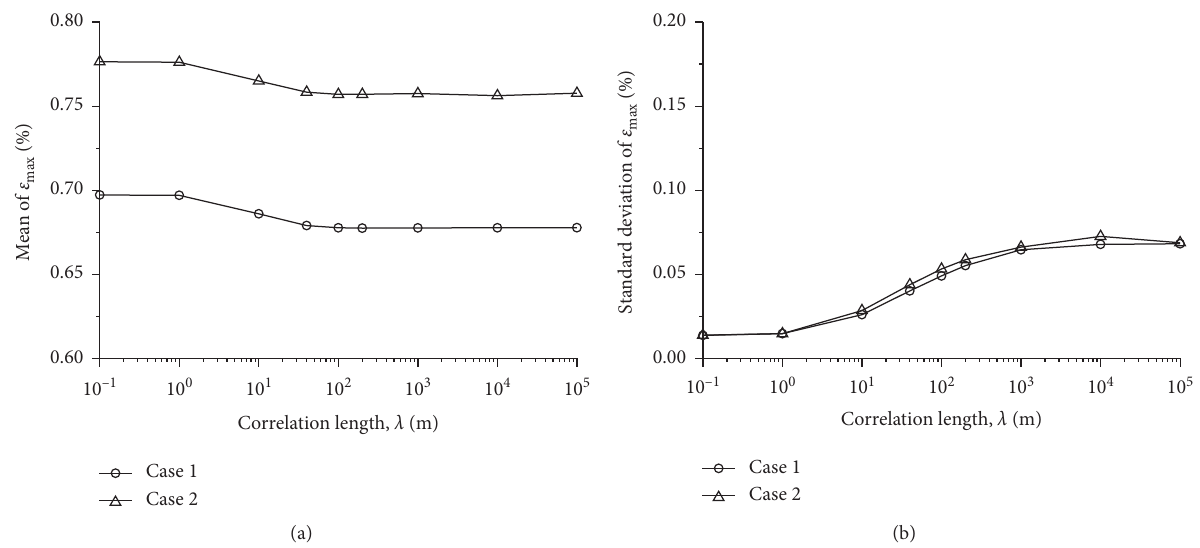
max : (a) mean of ε max ; (b) standard deviation